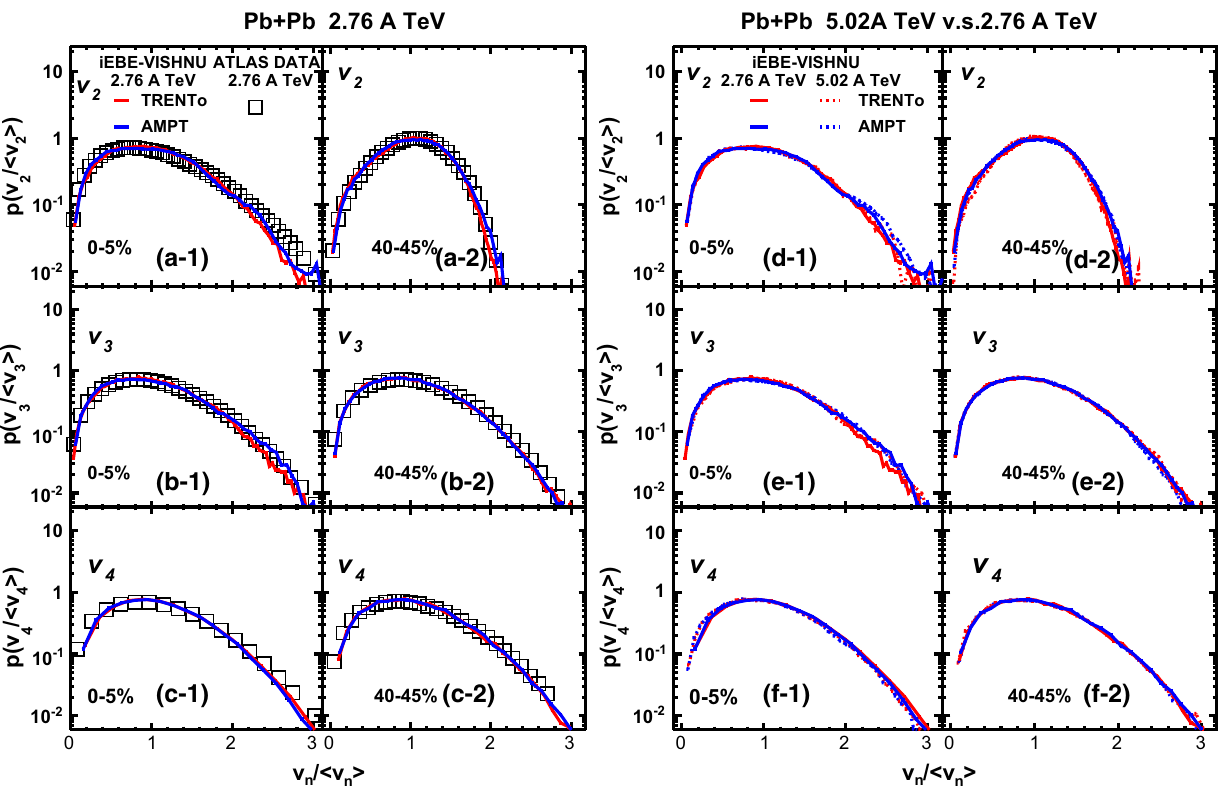
Fig. 7 The scaled event-by-event v n distributions in 0–5 and 40–45% Pb + Pb collisions at 2.76 and 5.02 A TeV, calculated from iEBE-VISHNU with TRENTo and AMPT initial conditions. The experimental data at 2.76 A TeV are taken from the ATLAS paper [28]